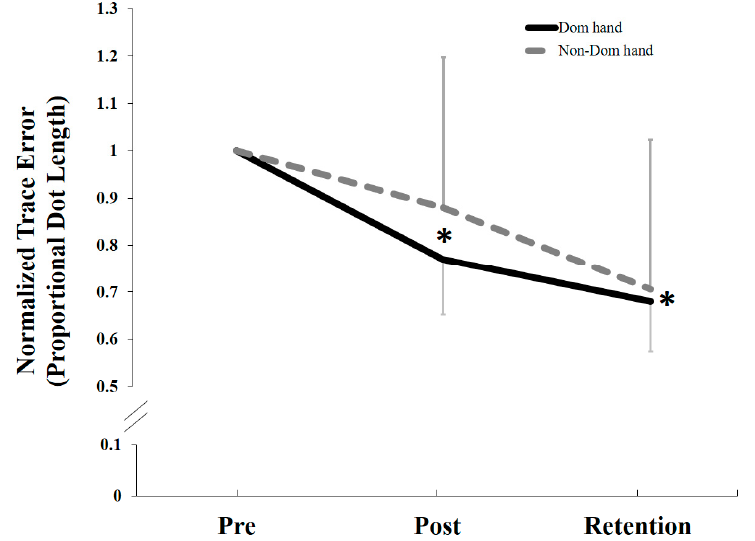
Figure 6. Normalized mean proportional trace error changes by groups (Dom vs. Non-Dom). Both groups improved in accuracy following motor acquisition and retention. There was a significant overall effect of TIME (* p < 0.0001), but no significant interaction effect TIME by GROUP. Error bars represent SD. * represents the significant differences from baseline over time.